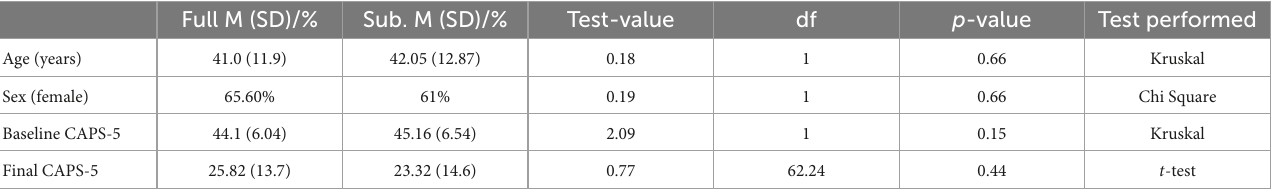
TABLE 1A Full clinical study compared to sub-study.